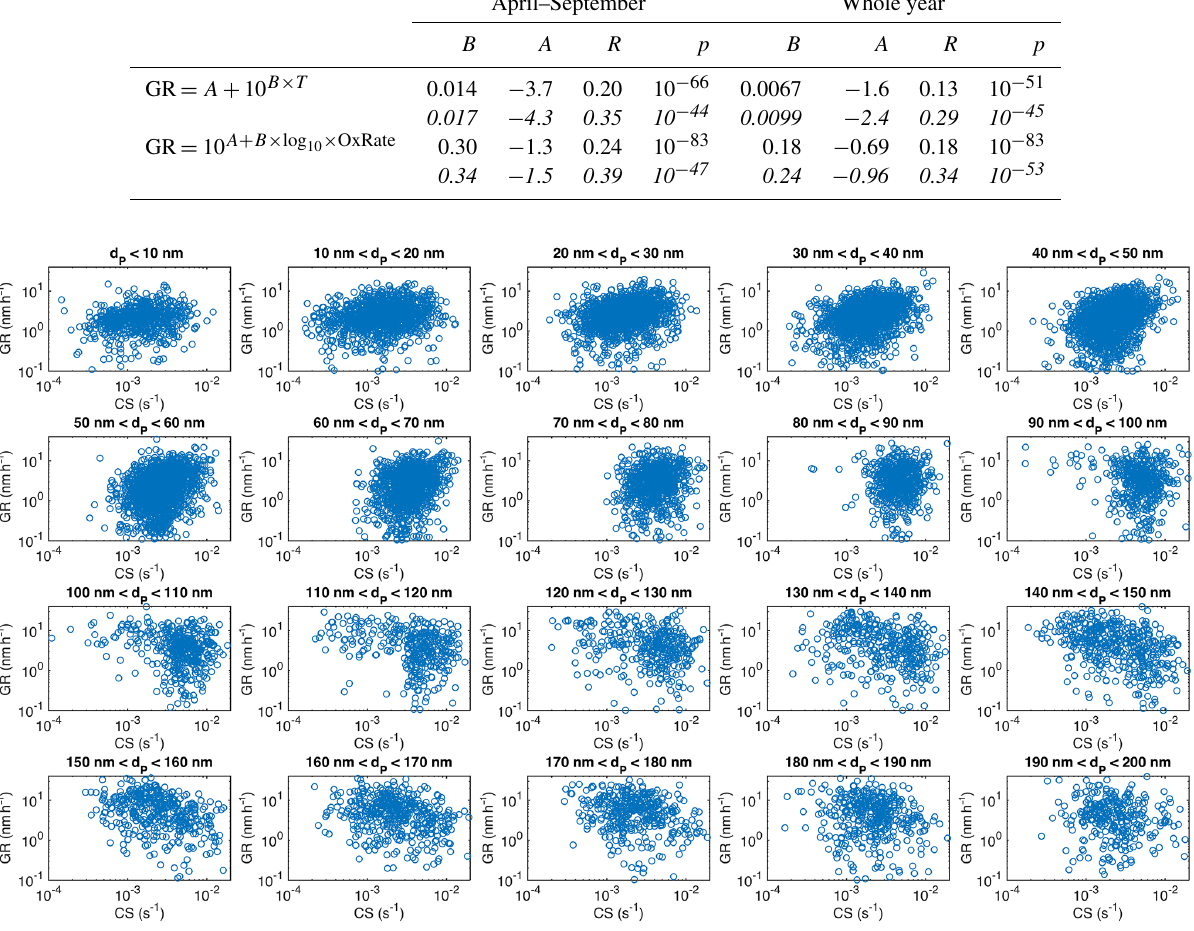
Figure 7. Growth rates with duration >2h during April–September as a function of condensation sink in size